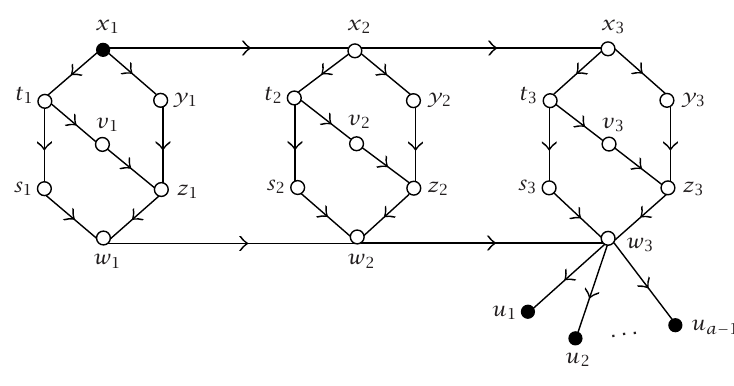
Figure 2.1 . An oriented graph D with h(D) = a and g(D) = b = a +